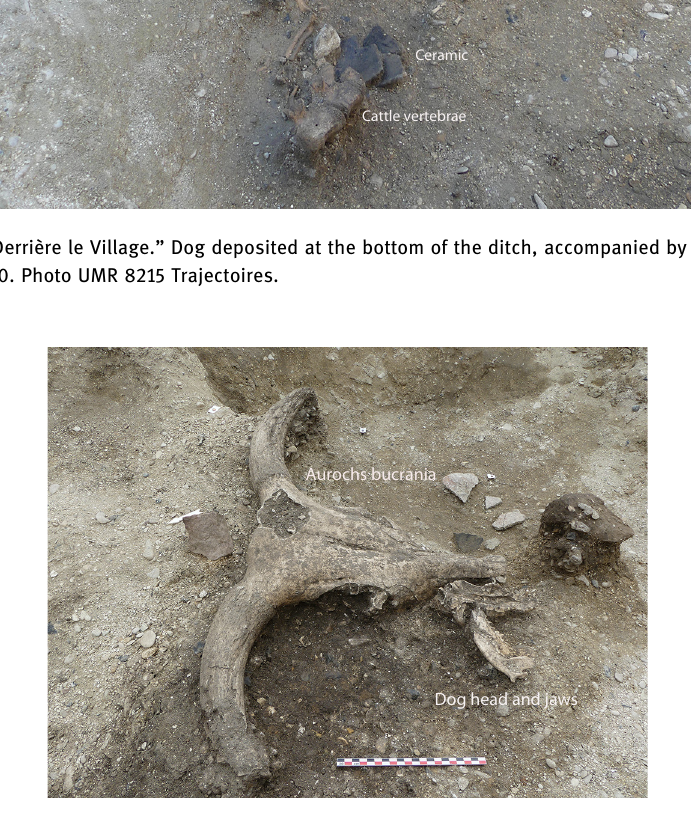
Figure 6: Menneville “ Derrière le Village. ” Female aurochs bucrania and dog skull with its mandibles, accompanied by stoneware and sherds, segment 600. Photo UMR 8215